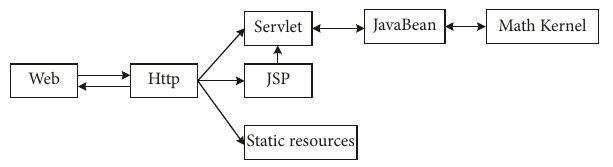
Figure 5: The overall model of the